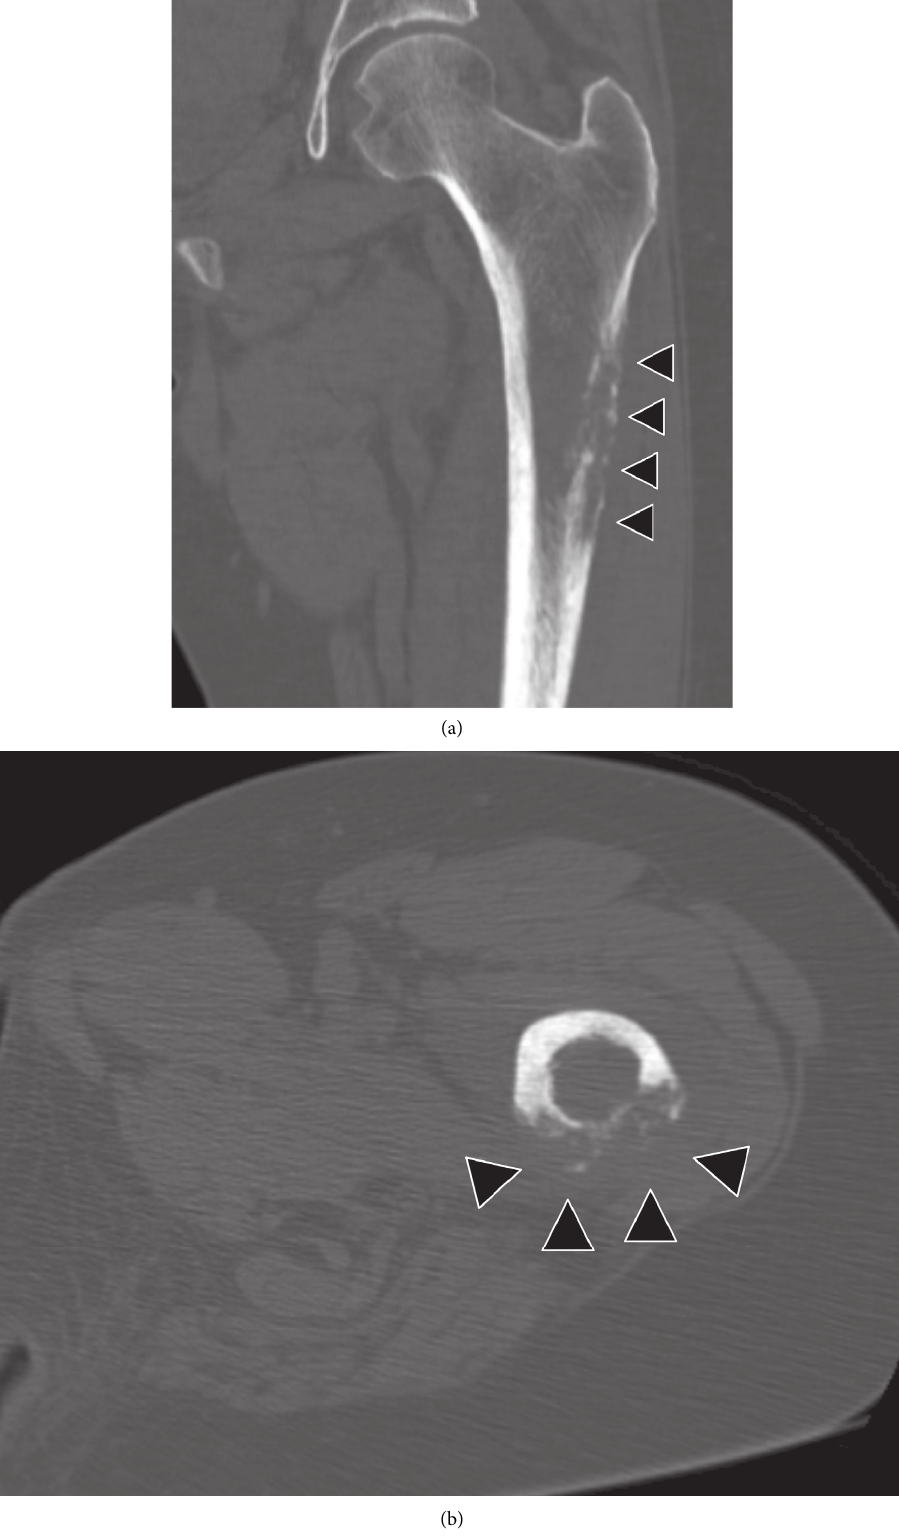
Figure 1: Computed tomography at first visit showing a purely osteolytic lesion on the left femur (arrowhead). (a) Coronal view and (b) axial